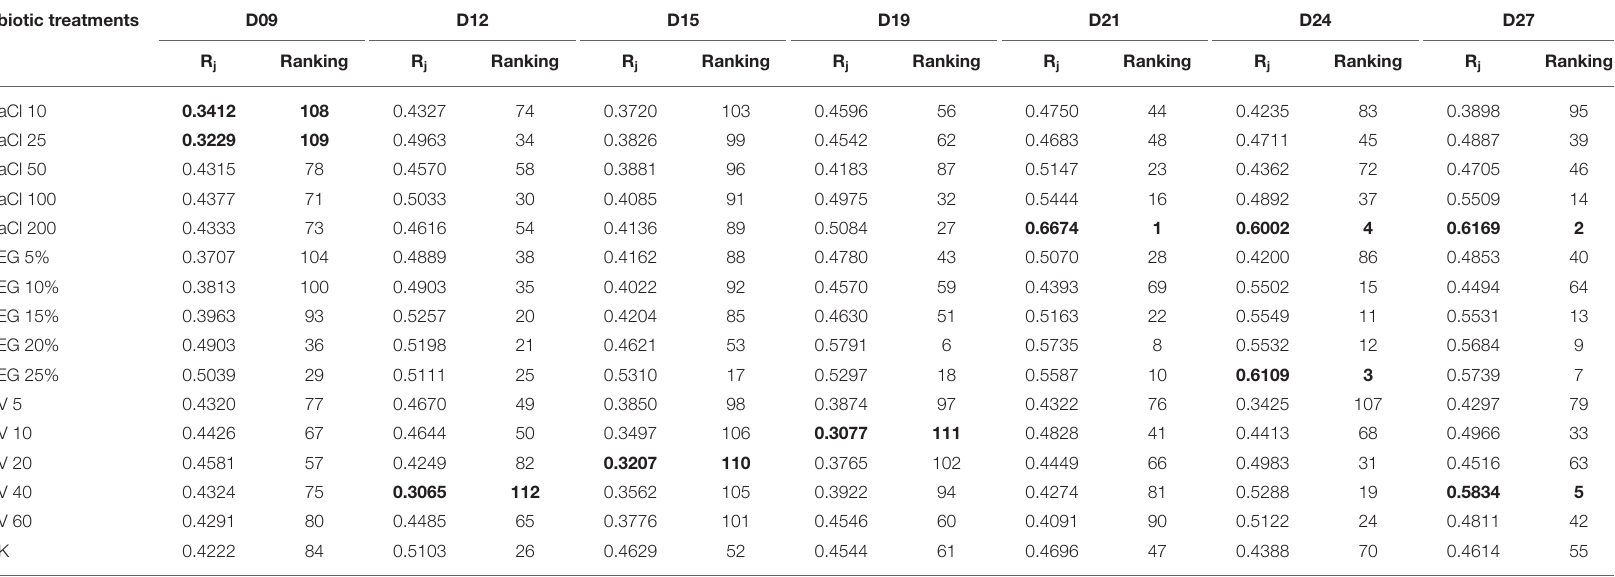
TABLE 1 | TOPSIS ranking results of wheatgrass phytochemicals of different seedling ages under different abiotic